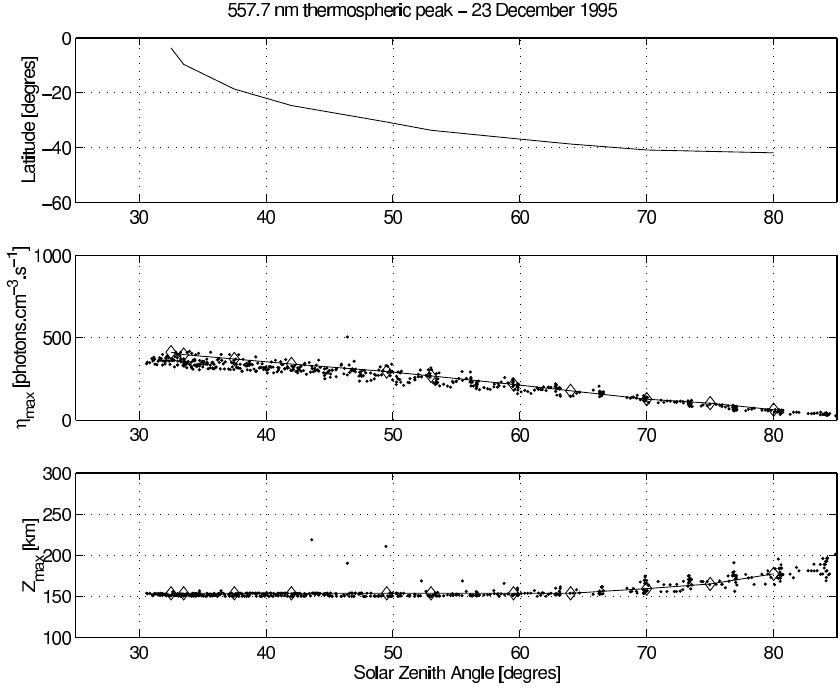
Fig. 10. 557.7nm oxygen thermospheric line – 23 December 1995 – f 10 . 7 = 71 . 2 ,A p = 8. Dots correspond to WINDII measurements and line/diamonds correspond to TRANSCAR